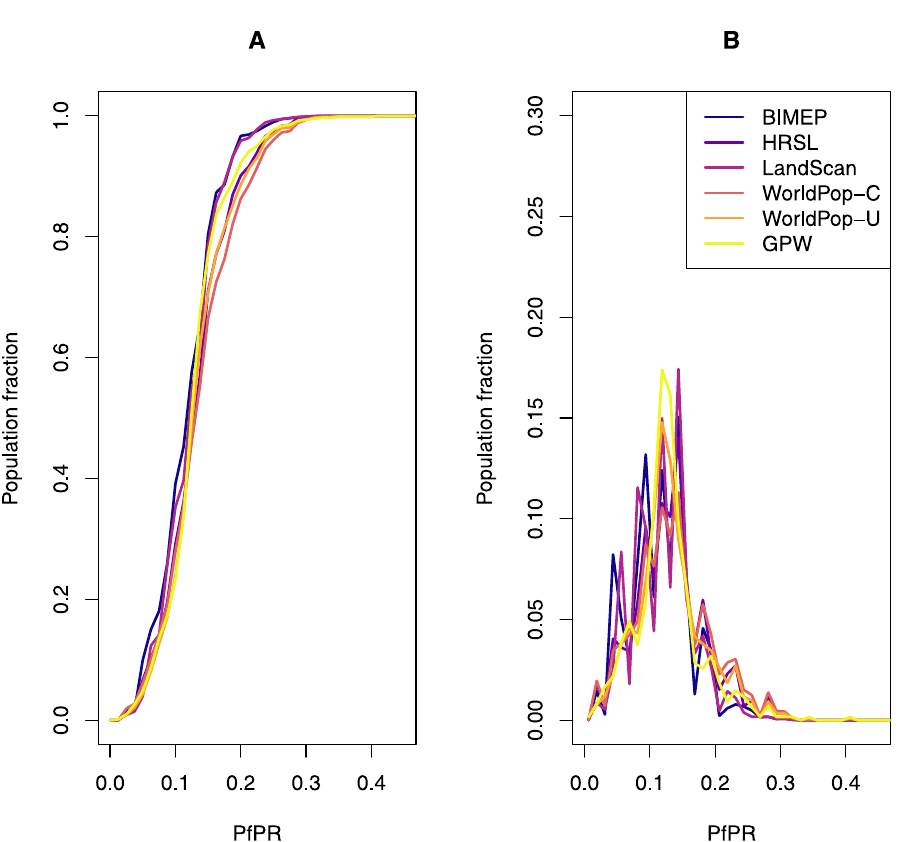
Fig 7. Fraction of the population according to Pf PR, expressed as cumulative distribution (A) and probability density functions (B).